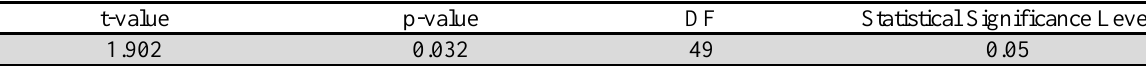
Seventh hypothesis at 95% confidence level t-value p-value DF